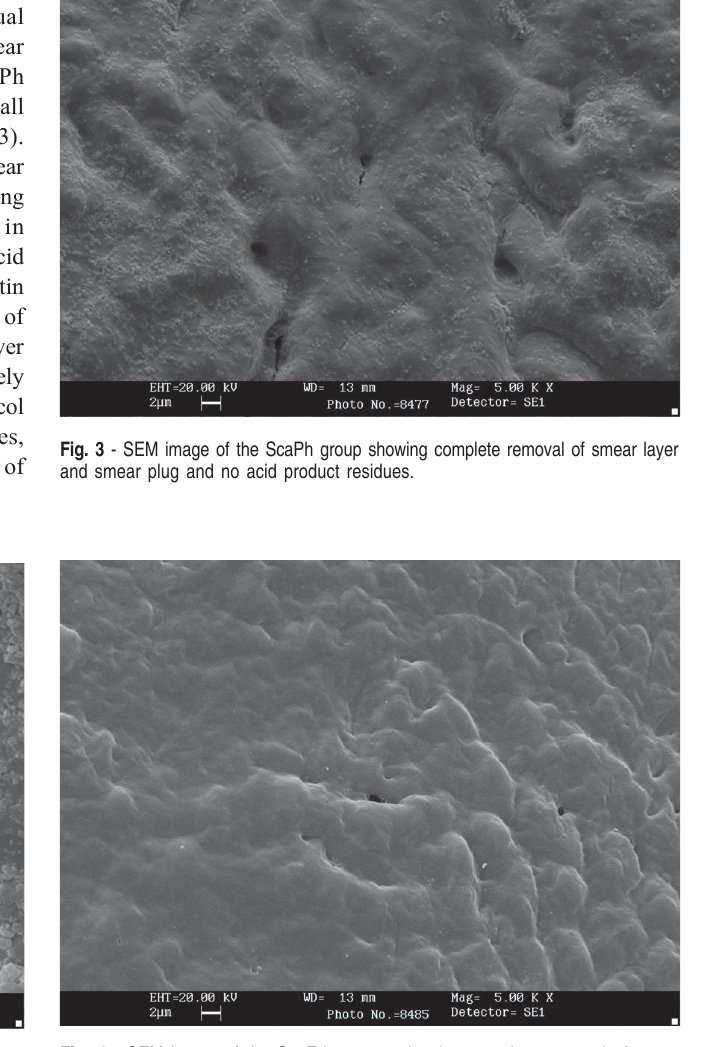
Fig. 1 - SEM image of the Cont group showing calculus and debris over root dentin, covering the entire root surface.